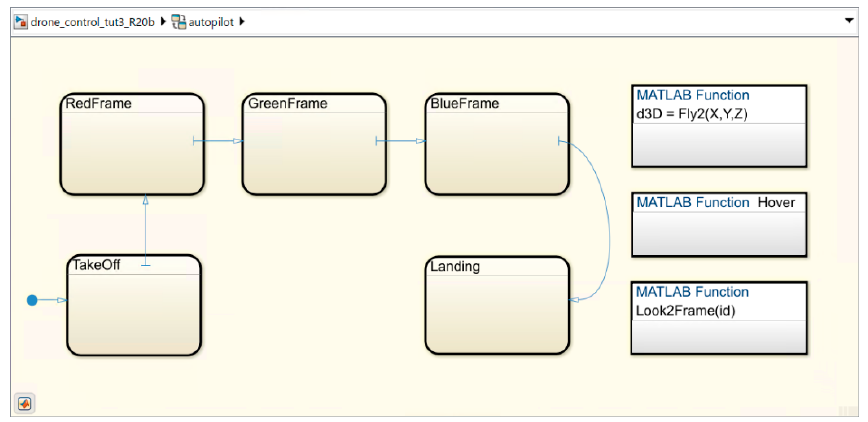
Figure 7. Detail of the autopilot Stateflow block.